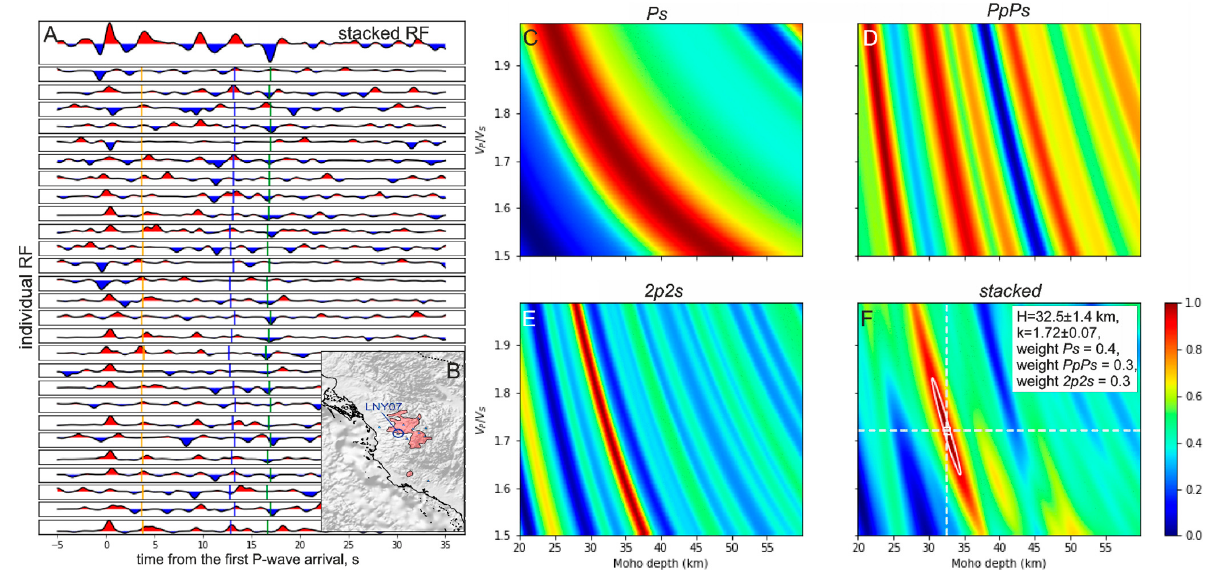
Figure 7. Results of the H-k stacking for the station LNY07 located in Harrat–Lunayyir close to station LNY06 shown in Figure 5, but outside the area of recent volcanic activity. Note that the Vp/Vs ratio for station LNY07 is significantly lower. ( A ): Individual receiver functions (Q-component). The upper trace is the average of all traces. Red, blue, and green hatches mark the theoretical arrivals of the Ps , PpPs and 2p2s phases, respectively. ( B ). The location of the station on the map. ( C – E ): Grid search results for three individual phases Ps , PpPs and 2p2s . ( F ): Result of stacking of the results for all phases. The white dashed lines mark the best solution. The parameters of stacking and results for H and k determination are shown on the panel F.